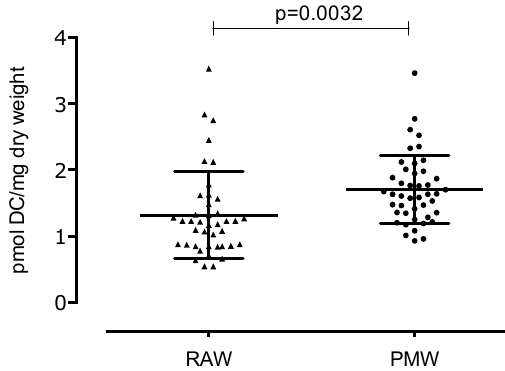
Figure 1. Concentration of the first stage of lipoperoxidation: dienes conjugates in reproductive-aged women (RAW) and postmenopausal women (PMW).